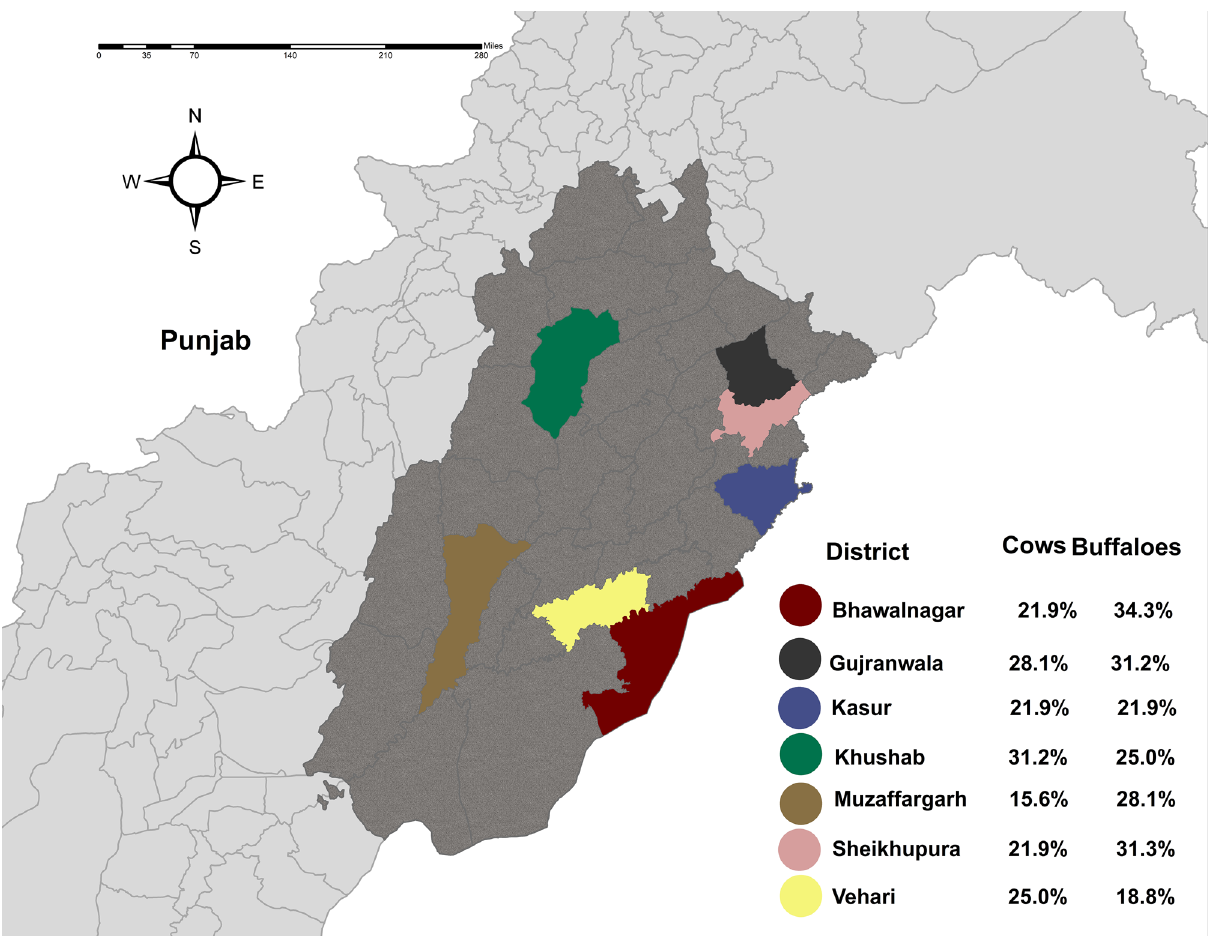
Figure 1. Seroprevalence of Q fever in large ruminants in seven districts of Punjab,